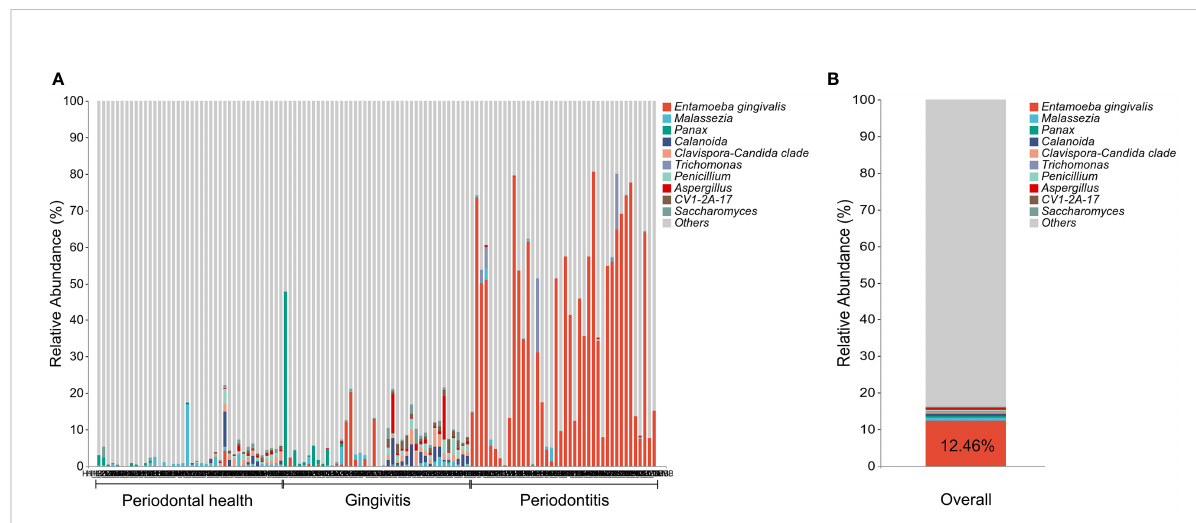
FIGURE 1 The prevalence and relative abundance of Entamoeba gingivalis ( E. gingivalis ) at the genus level. (A) The prevalence and relative abundance of E. gingivalis at the genus level among different periodontal condition. The top 10 most abundant genera are exhibited. (B) The relative abundance of E. gingivalis at the genus level in all samples. The top 10 most abundant genera are